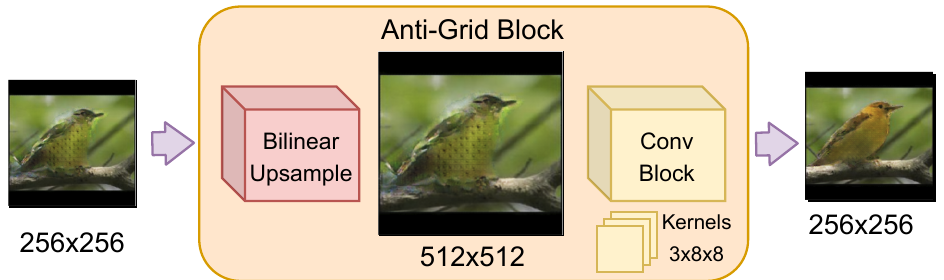
Figure 4. Single-step generation artifacts are shown along with the corresponding inputs and outputs.